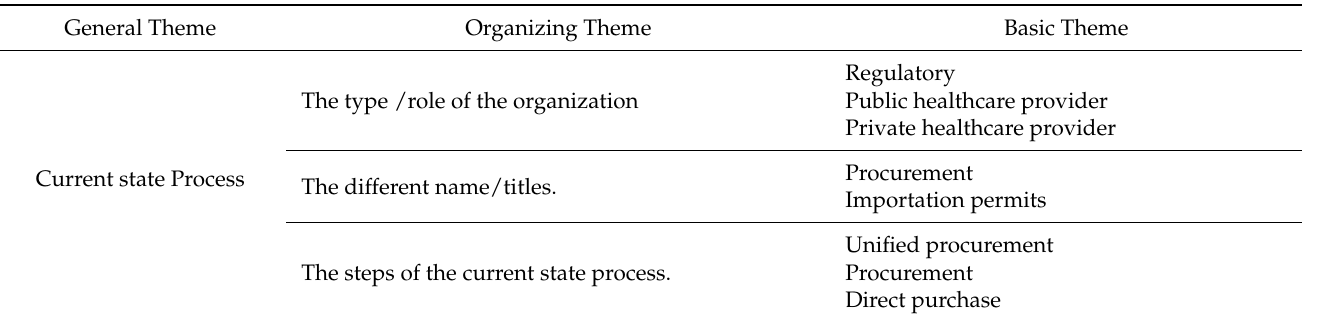
Table A2. Sample of Interview Analysis